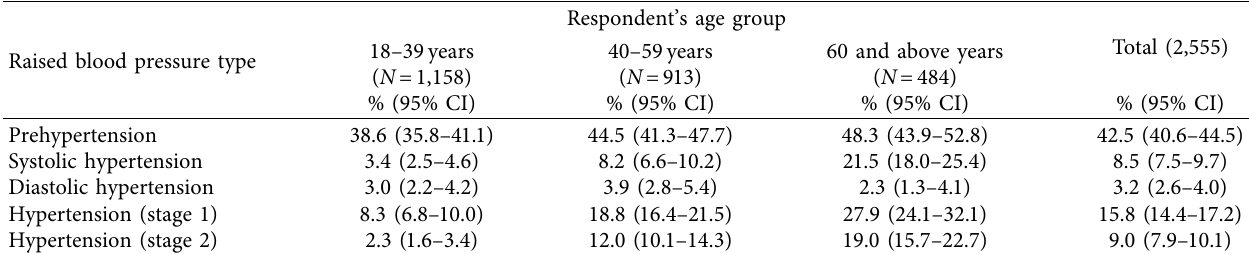
Table 2: Various types of hypertension prevalence by age group within the surveyed population.